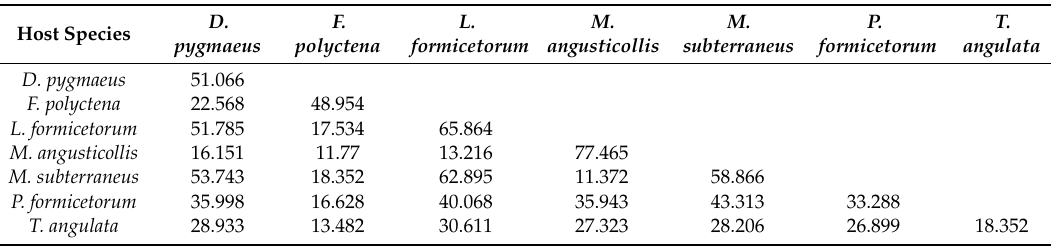
Table 1. Average similarity between and within groups of identified microbiota profiles. Profiles were grouped according to host